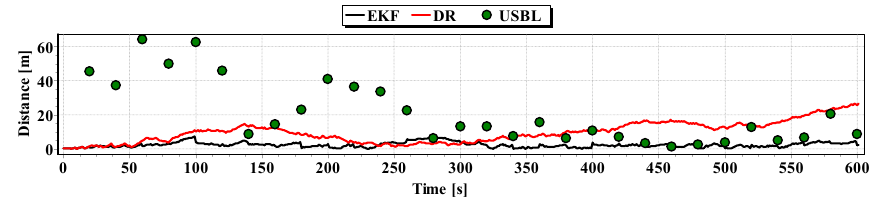
Figure 22. Graph distancing the reference position from the position determined by EKF and DR